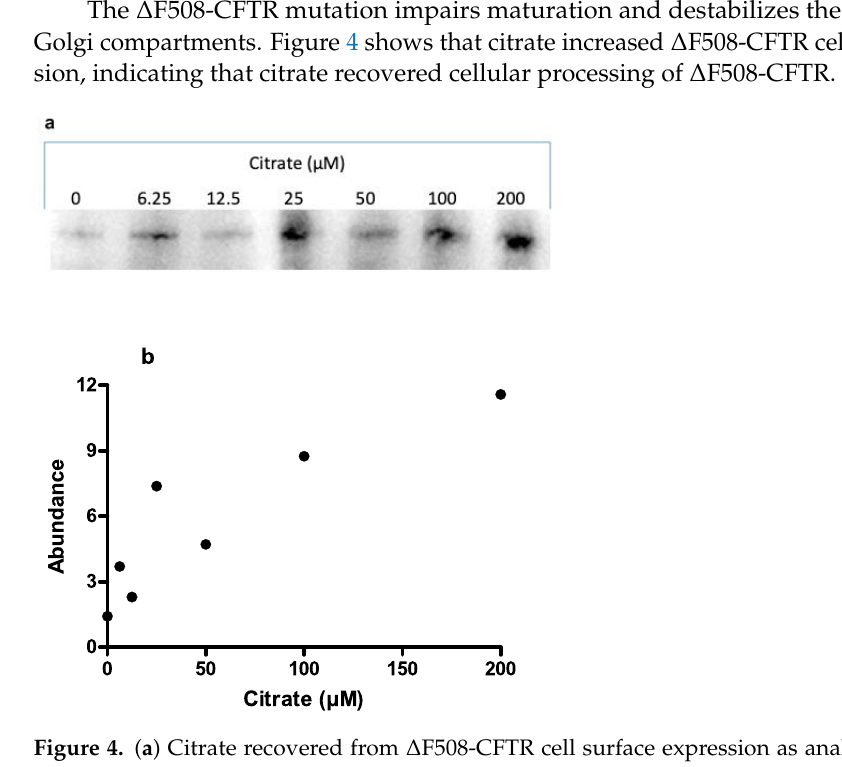
Figure 3. Citrate stimulated iodide efflux. CFTR can also export iodide instead of chloride. 16HBE14o- or CFBE41o- were loaded with iodide and the iodide concentration was measured by an iodide-sensitive electrode in 1 min intervals. The bar indicates the time period of exposure to 100 µM of citrate.